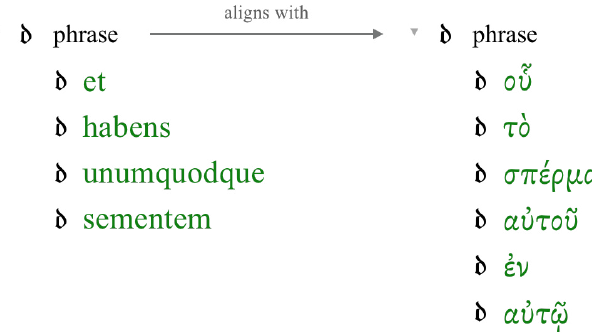
Figure 11: Alignment between phrases when word-to-word alignment is not possible (Gen 1:12) The Greek, Aramaic, and Syriac content pools are all aligned with the Hebrew because they are translations of the Hebrew.20 When a user asks to compare a Greek local text with a Syriac local text, that relationship is traced through the Hebrew content pool.